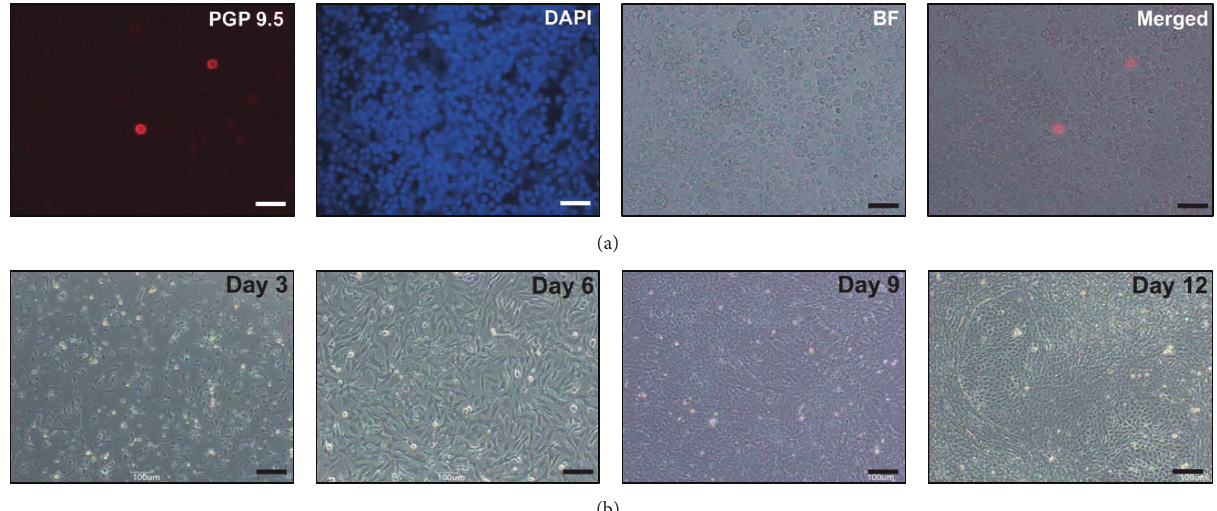
Figure 1: Culture and immunocytochemistry of isolated feeder cells. The isolated feeder cells were stained with PGP 9.5 and DAPI (a) and cultured in the StemPro-34 medium for 12 days (b). Scale bars indicate 30 𝜇 m and 100 𝜇 m in panels of (a) and (b),